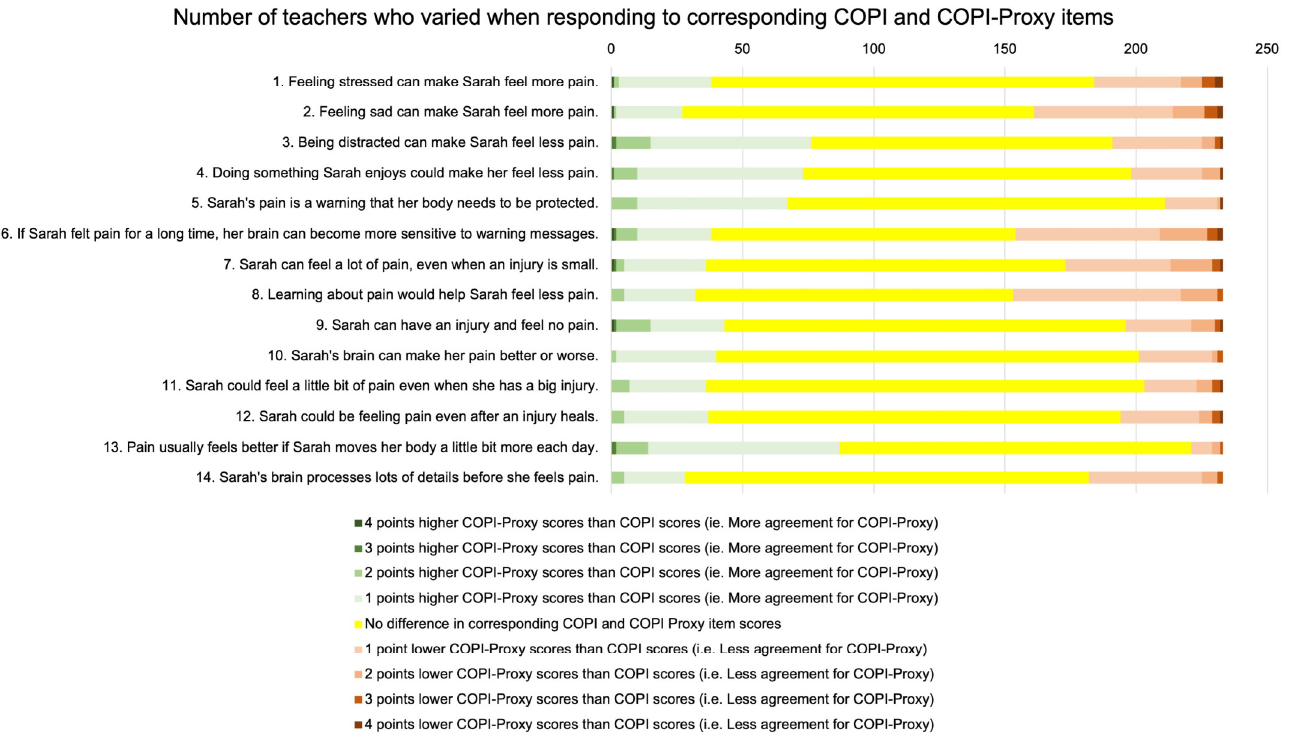
Table 5. Results of univariate regression analyses between higher COPI-Proxy total scores (n = 233) and other variables. Variable